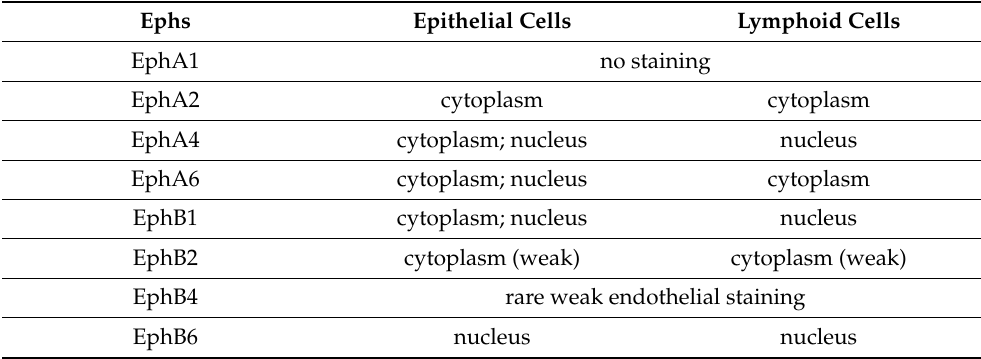
Table 1. Subcellular topography of Ephs.